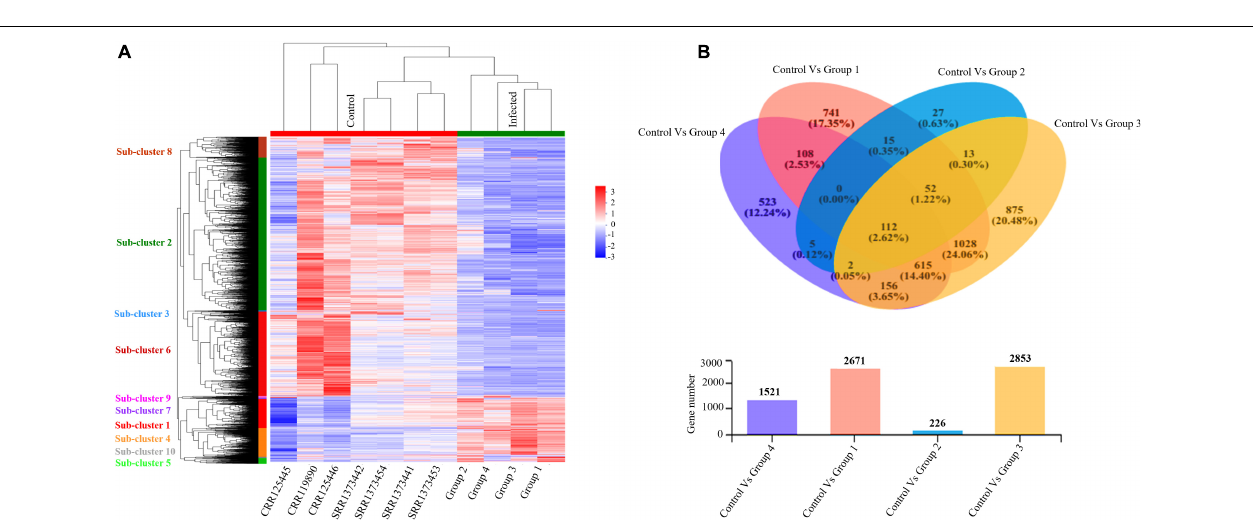
FIGURE 3 | Enrichment analysis of differentially expressed genes in COVID-19 cohort. (A) Bar Graph representation of top twenty clusters with corresponding enriched terms across a provided list of DEGs colored by –log10(P) on the X-axis. The functional annotation terms and their corresponding categories are M (canonical pathways), GO (Gene Ontology), WP (Wiki pathways), R-HSA (Reactome Gene Sets), and hsa (KEGG pathway). (B) Functional enrichment analysis of DEGs compared between infected and healthy control groups illustrating the dysregulated regulatory pathways in COVID-19 cohort data. The network cluster labels are added manually. The nodes are represented as pie charts and colored by p -value, where enriched networks having more genes tend to have a higher p -value.